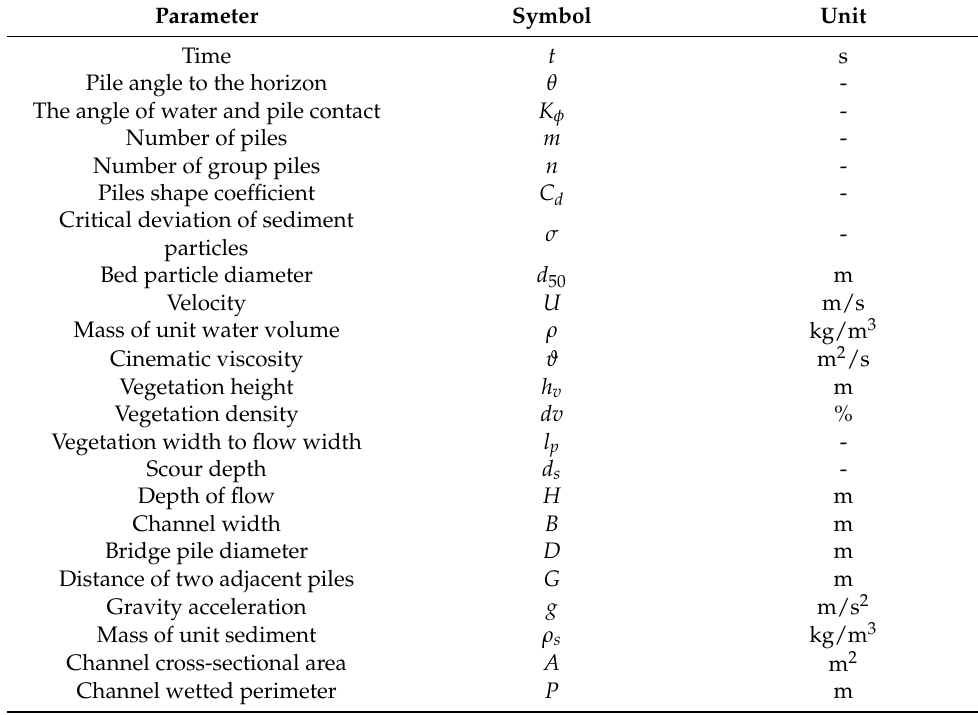
Table 1. Parameters affecting the scouring